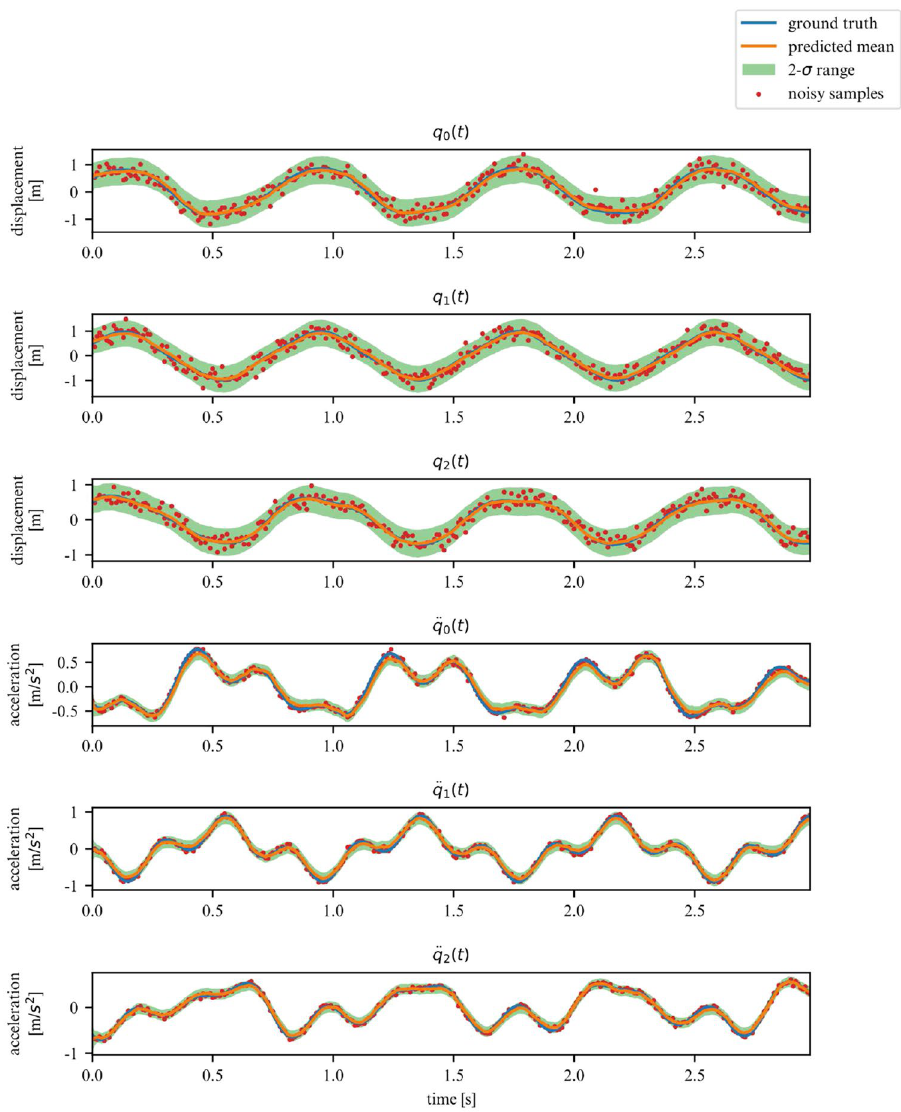
Figure 9. Observations for a linear 3DOF